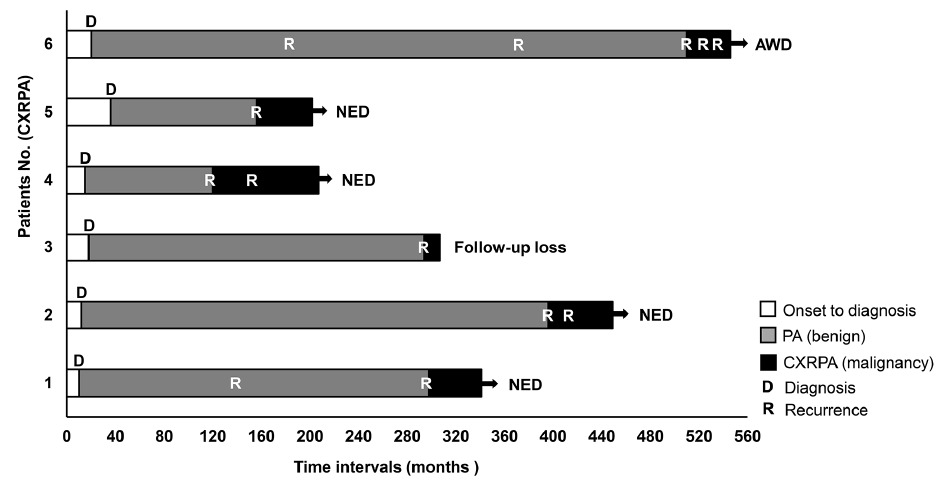
Figure 1. Clinical courses in patients with carcinoma ex recurrent pleomorphic adenoma. AWD, Alive with disease; NED, no evidence of disease.